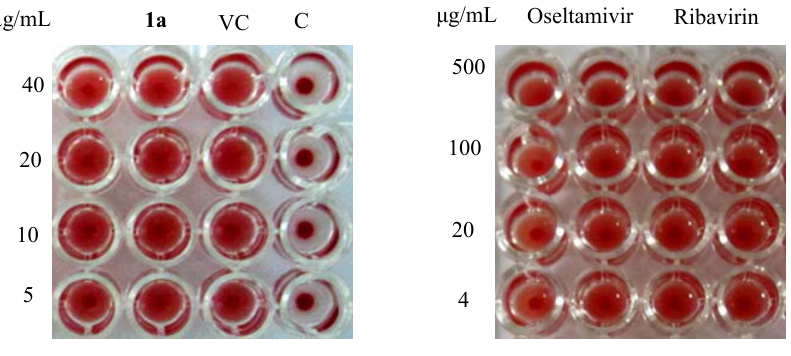
Figure 2. Hemagglutination inhibitory activity of 1a .